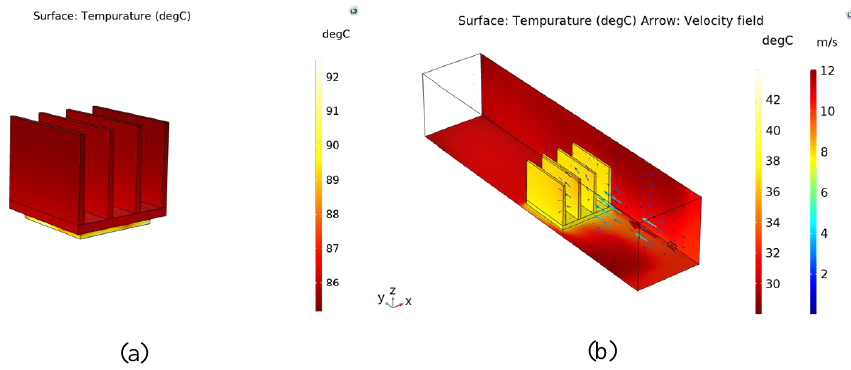
Figure 11. Simulation model: ( a ). natural convection heat dissipation; ( b ). synthetic jet heat dissipa- tion.